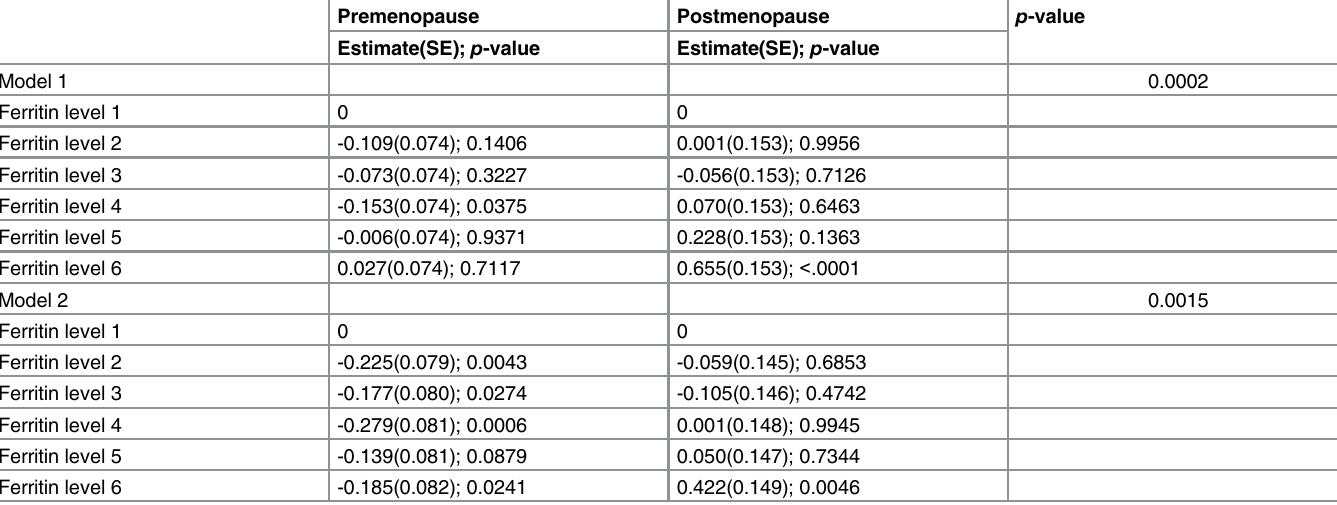
Table 8. Estimated regression coefficient for HOMA-IR by serum ferritin groups.